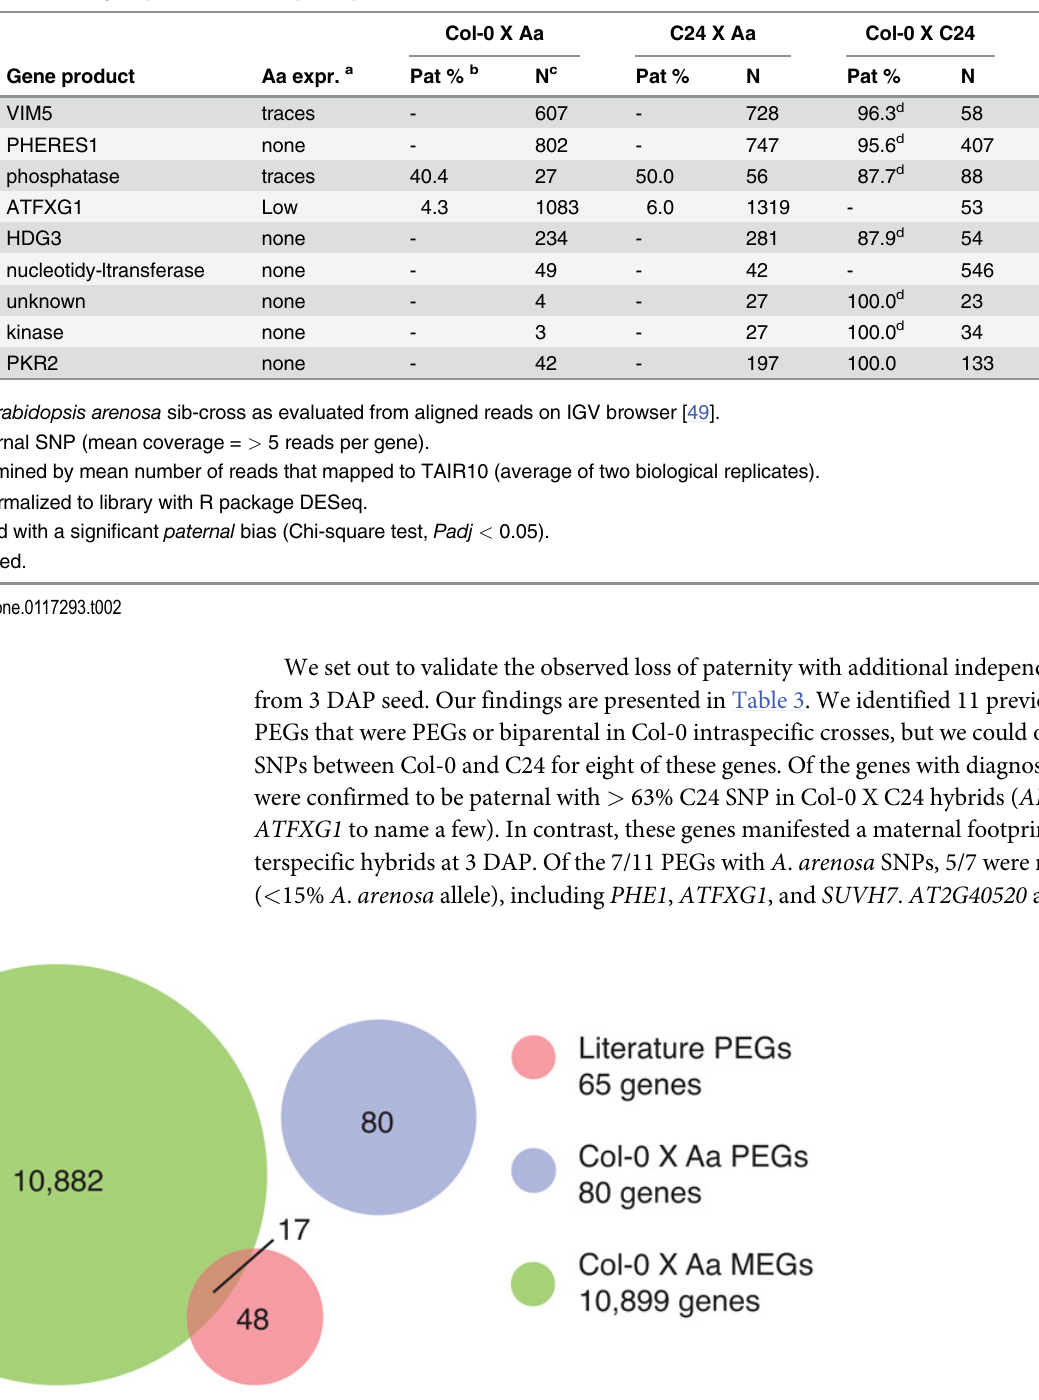
Fig 4. Interspecific paternally expressed genes vary from known imprinted genes. Candidate maternally and paternally expressed genes identified in Col-0 X A . arenosa were compared to paternally expressed genes identified in previous parent-of-origin studies. The number of candidate genes for each classification is given. Paternally expressed genes in Col-0 X A . arenosa crosses display no overlap with literature genes. This class of genes was designated as de novo PEGs in interspecific crosses. In addition, 17 known paternally expressed genes were identified as candidate maternally expressed genes in Col-0 X A . arenosa